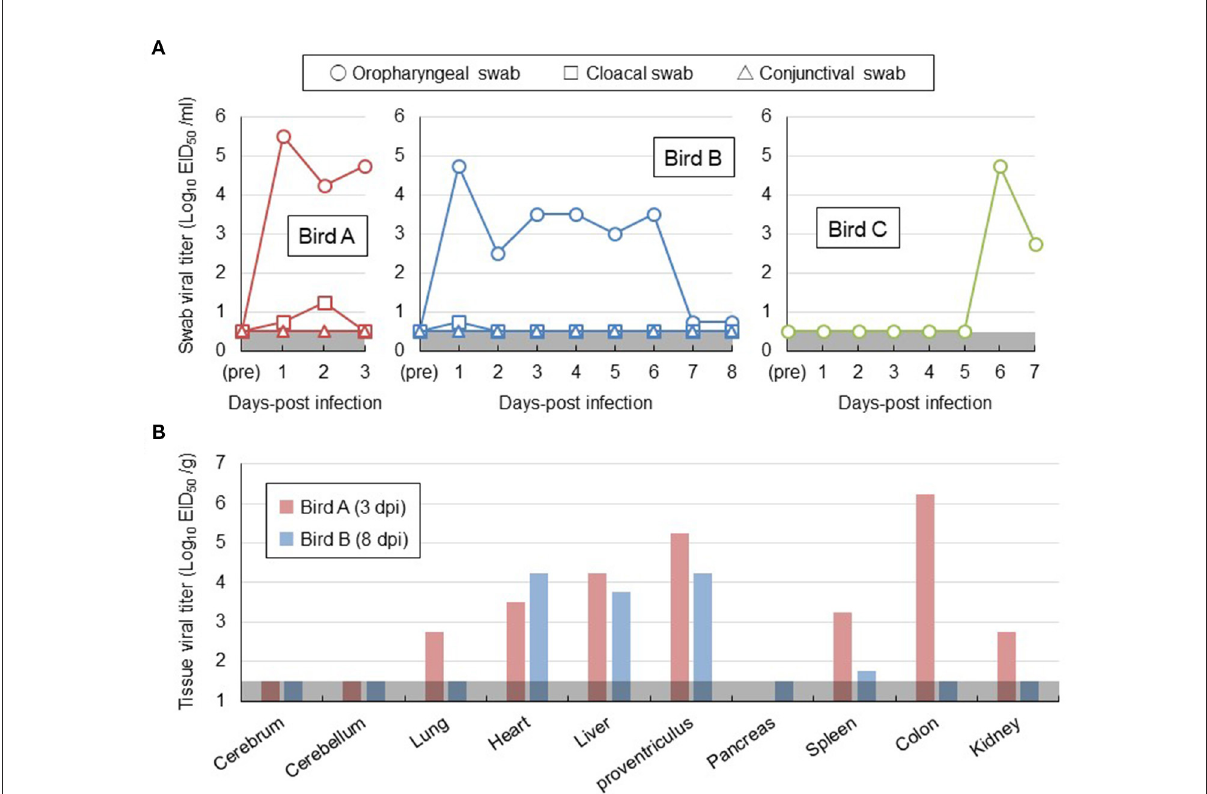
FIGURE1 Viral replication in white-tailed sea eagles experimentally infected with H5N6 HPAI virus. (A) Temporal change of viral titers in swab samples. Viral titers in oropharyngeal swab (circle), cloacal swab (square), and conjunctival swab (triangle) samples collected from the two inoculated eagles (birds A and B) and from the contact eagle (bird C) that was housed adjacent to bird B were determined using embryonated chicken eggs. The detection limit was below 0.5 log EID 50 /mL. (B) Viral titers in organs obtained from the two inoculated eagles. Birds A and B (i.e., the two inoculated eagles) were euthanized on days 3 and 8 post-inoculation, respectively. Organs were collected, homogenized, and subjected to virus titration in embryonated chicken eggs. The detection limit was below 1.5 log EID 50